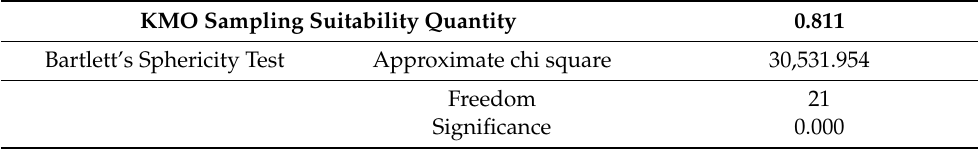
Table 2. KMO and Bartlett’s test of the